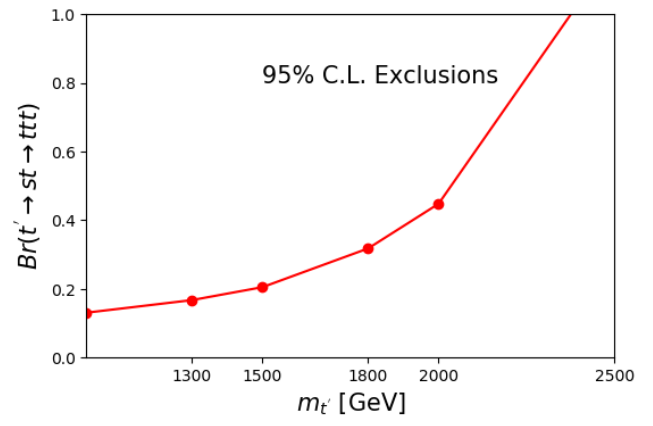
Figure 4 . The 95% C.L. upper limit with L = 3000 fb (cid:0) 1 on the branch fraction of t 0 ! st ! t (cid:22) tt as a function of top-partner mass m t 0